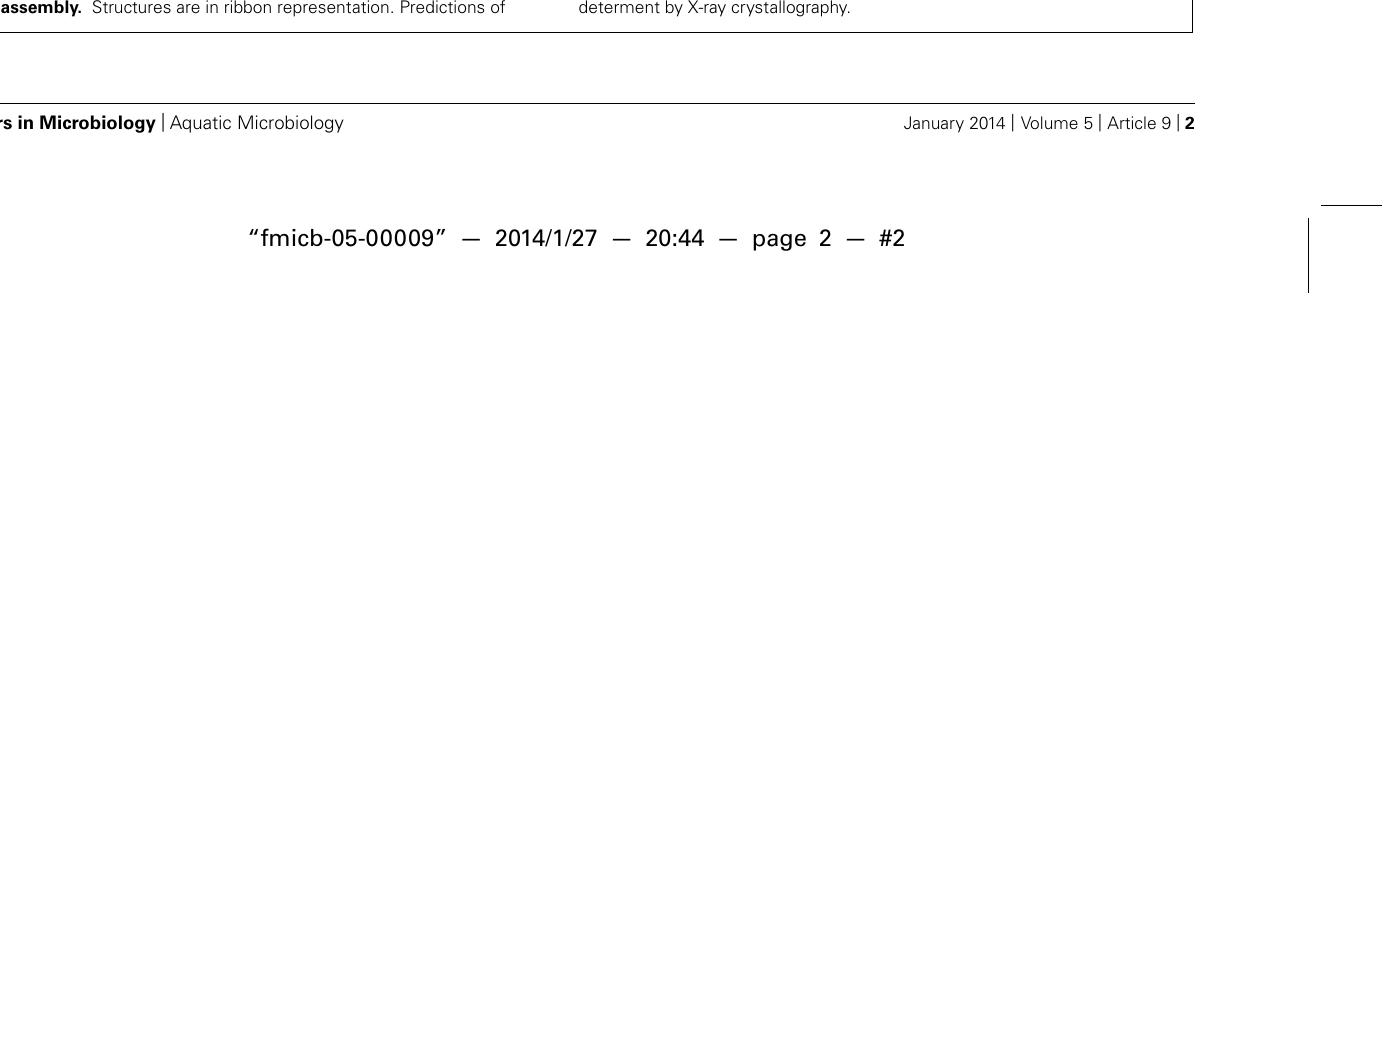
FIGURE 1 | Protein structure predictions that are involved in protein sorting, magnetosome membrane invagination, and magnetosome chain assembly. Structures are in ribbon representation. Predictions of